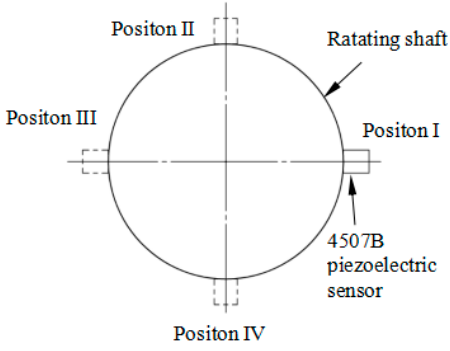
Figure 13. Paste position diagram of 4507B piezoelectric acceleration sensor.